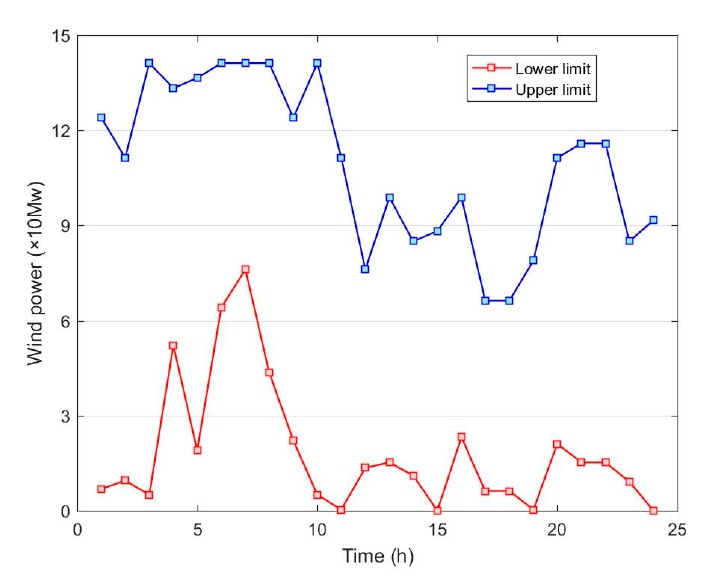
Figure 7. Interval Prediction of Wind Power.